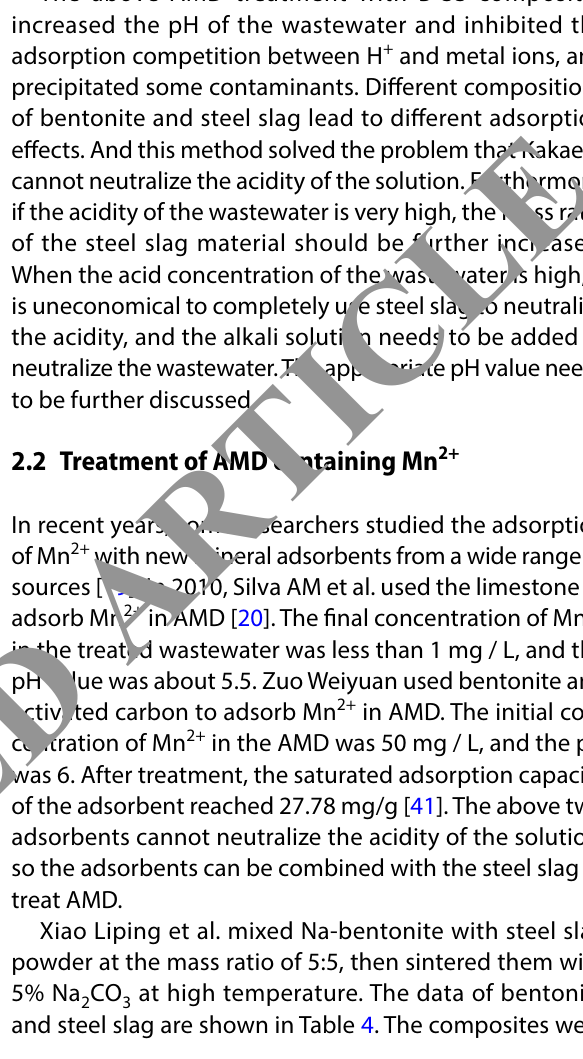
Table 2 The data of bentonite and steel slag Type